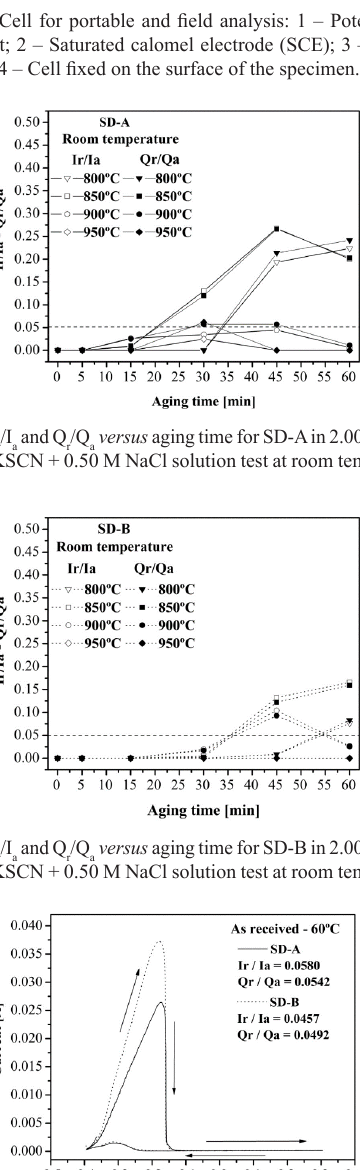
Figure 4. DL-EPR curves of un-aged SD-A and SD-B tested at 60 ° C in 2.00 M H SO + 0.01 M KSCN + 0.50 M NaCl 2 4